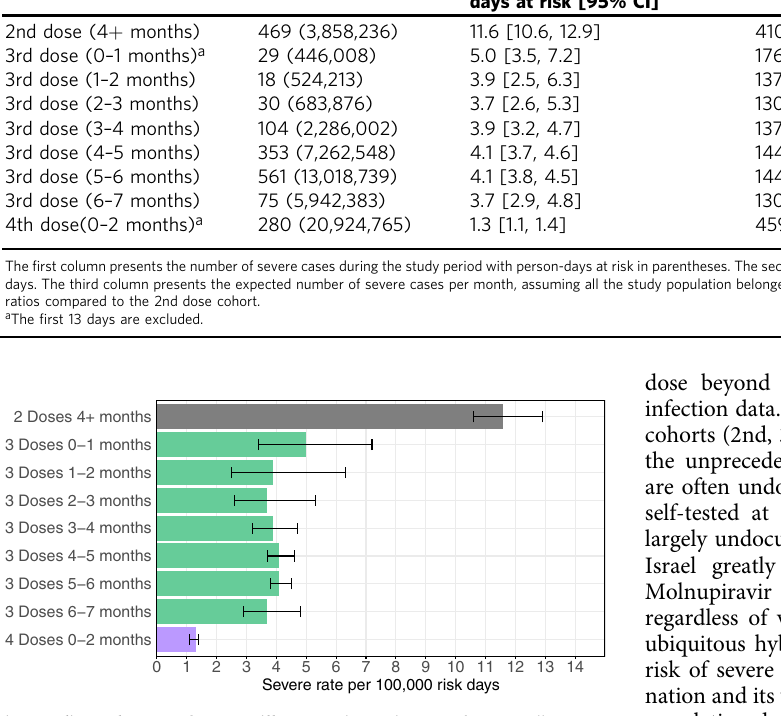
Fig. 1 Adjusted rates of severe illness. Adjusted rates of severe illness per 100,000 risk days obtained from Poisson regression analysis for the study period January 16, 2022 – March 12, 2022, adjusted for age category (60 – 69, 70 – 79, 80 + ), sex, sector, and exposure (based on epidemiological week). Error bars represent 95% con fi dence intervals, which are not adjusted for multiplicity.